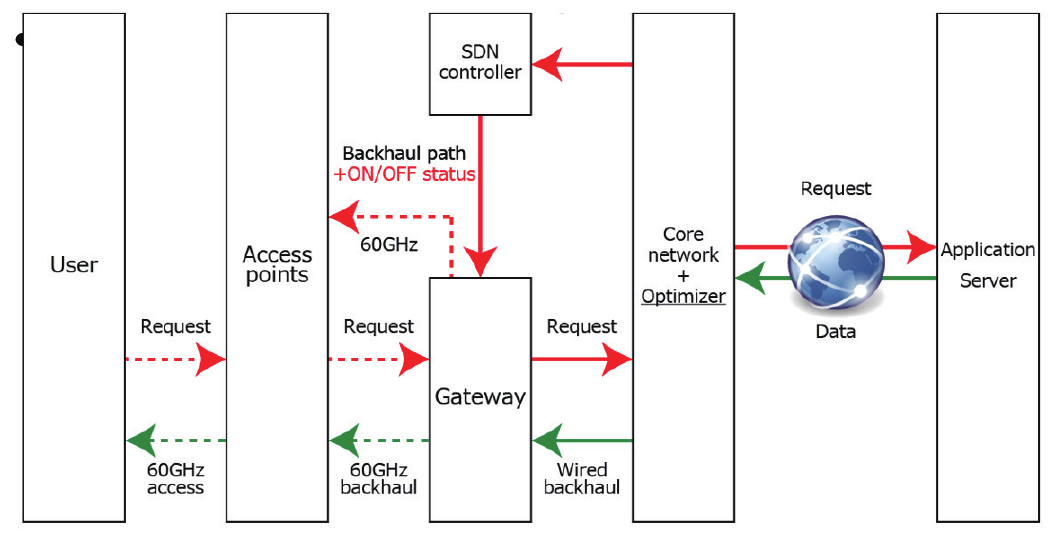
Figure 4. Conventional C-plane (User centric ON).